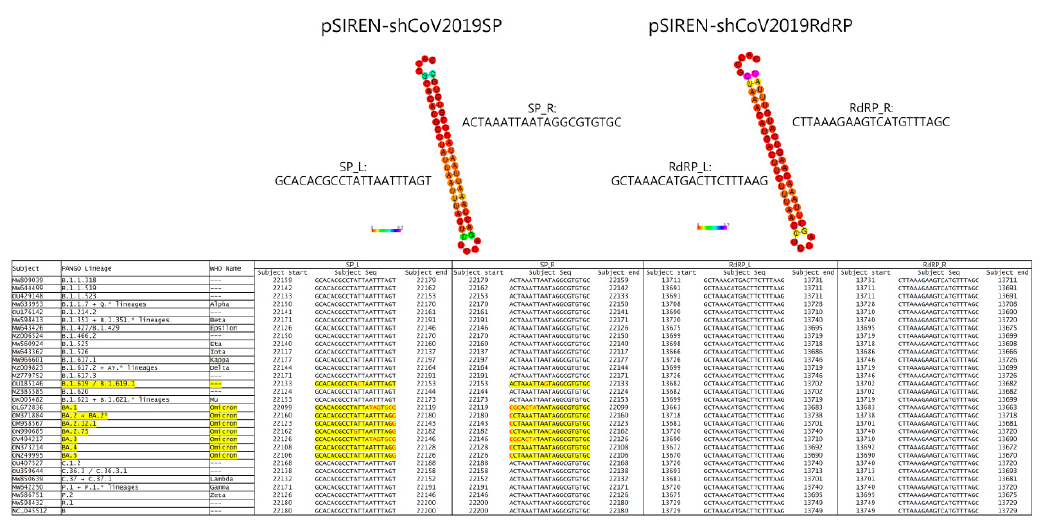
Figure 1. Conservation of targeting of shCoV2019SP and shCoV2019RdRP among different variants of SARS-CoV-2.